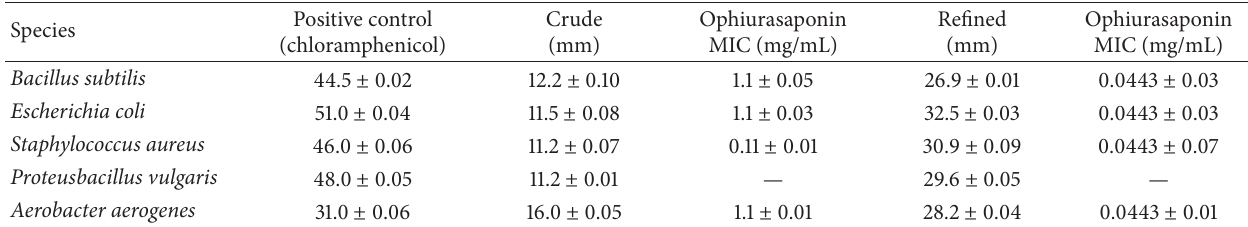
Table 2: Inhibition of ophiurasaponin from Ophiopholis mirabilis to bacteria 𝑛 = 3 .